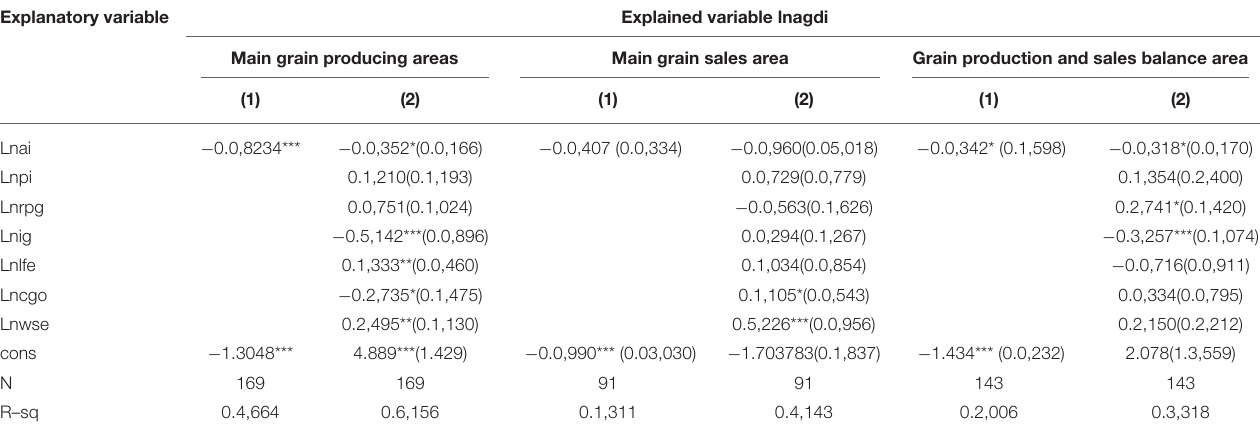
TABLE 7 | Partition regression results. Explanatory